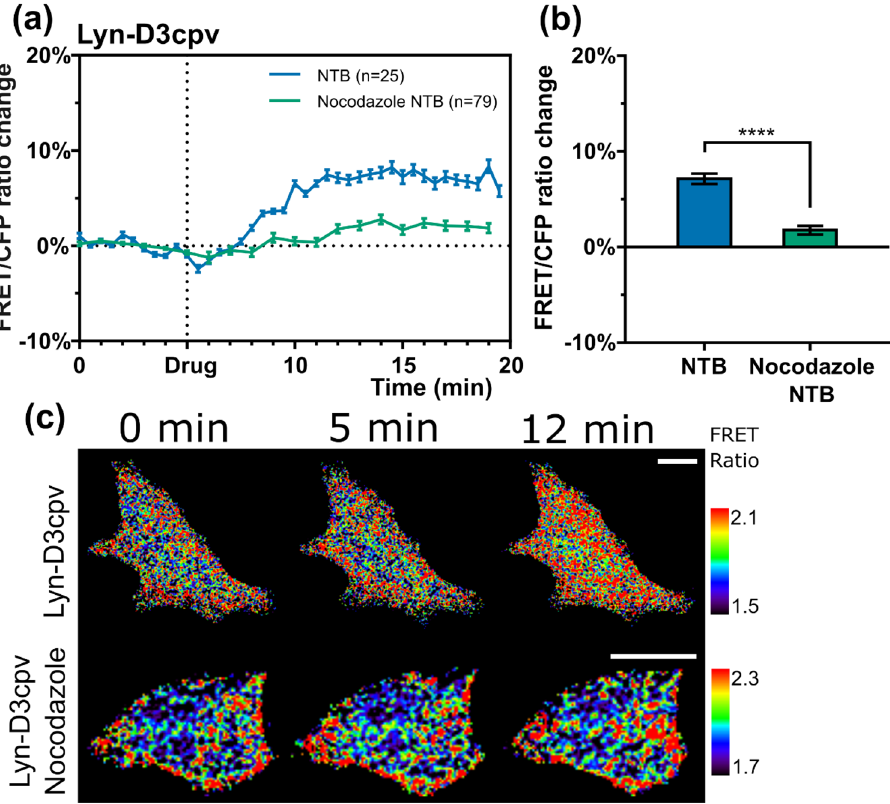
Figure 6. ( a ) Line graphs showing the effect of nocodazole pretreatment on TRPM7 activity. ( b ) Bar chart with the values of the fluorescence resonance energy transfer (FRET)/ enhanced cyan fluorescent protein (CFP) ratio change 12 min after the beginning of the experiment from ( a ). Student’s t test, **** P < 0.0001. NTB, naltriben; n, number of cells. Error bars in the line plots represent the standard error of the mean ( P < 0.05). ( c ) Time-lapse FRET ratio images of the Michigan Cancer Foundation-7 cells in false colors. The colored scale bar represents the range of the biosensor FRET/CFP emission ratios. The warmer the color of the pixel, the higher the Ca 2+ concentration. Scale bar = 20